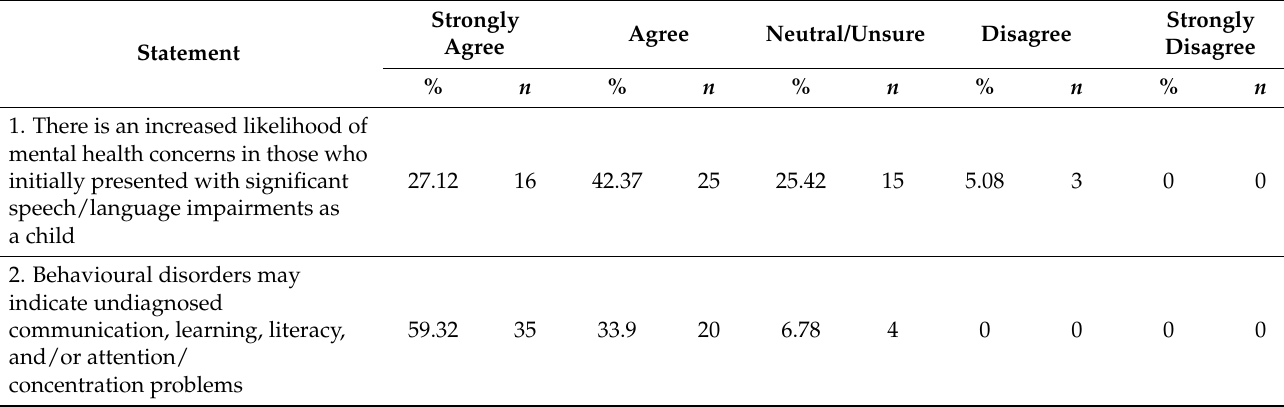
Table 4. Beliefs regarding communication and swallowing